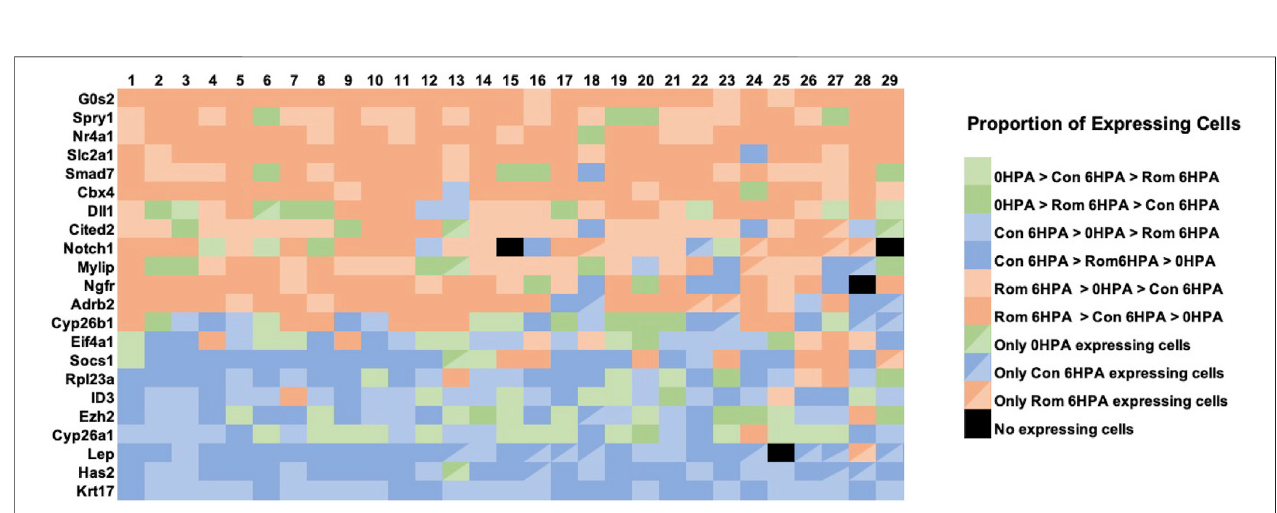
FIGURE 7 | The relative proportion of cells within snRNA-Seq libraries and clusters that expressed transcripts for romidepsin-modulated genes. For each of 22 romidepsin-modi fi ed genes (see text), the proportion of expressing cells was determined for each library (Day 0, Cont 6 HPA, and Rom 6 HPA) and cluster (1-29) combination. Then, genes were classi fi ed for each cluster according to the rank ordering of expressing cells among the libraries. In the fi gure, sienna/tan colors indicate classi fi cations where the highest proportion of expressing cells were observed in Rom 6 HPA, blue colors indicate classi fi cations where the highest proportion of expressing cells were observed in Cont 6 HPA, and green colors indicate classi fi cations where the highest proportion of expressing cells were observed in Day 0.